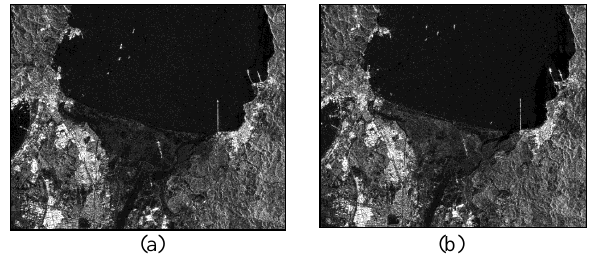
Figure 5. Result images of the registration and resize process: (a) Image before the disaster and (b) Image after the disaster The values of each pixel in a SAR image file are usually calibrated such that the pixel value in unit of “radar cross section”. These values are recorded in the SAR data file integers or floating point numbers, which can be converted to radar provided with the data. Since there is a strong preference for most of the energy to reflect away from the radar due to the side-looking geometry, the observed ratio is almost always less than one. The dB values are therefore usually negative, typically ranging from -5 dB (bright) to -20 dB or less (dark) (Comer and Harrower, 2013).